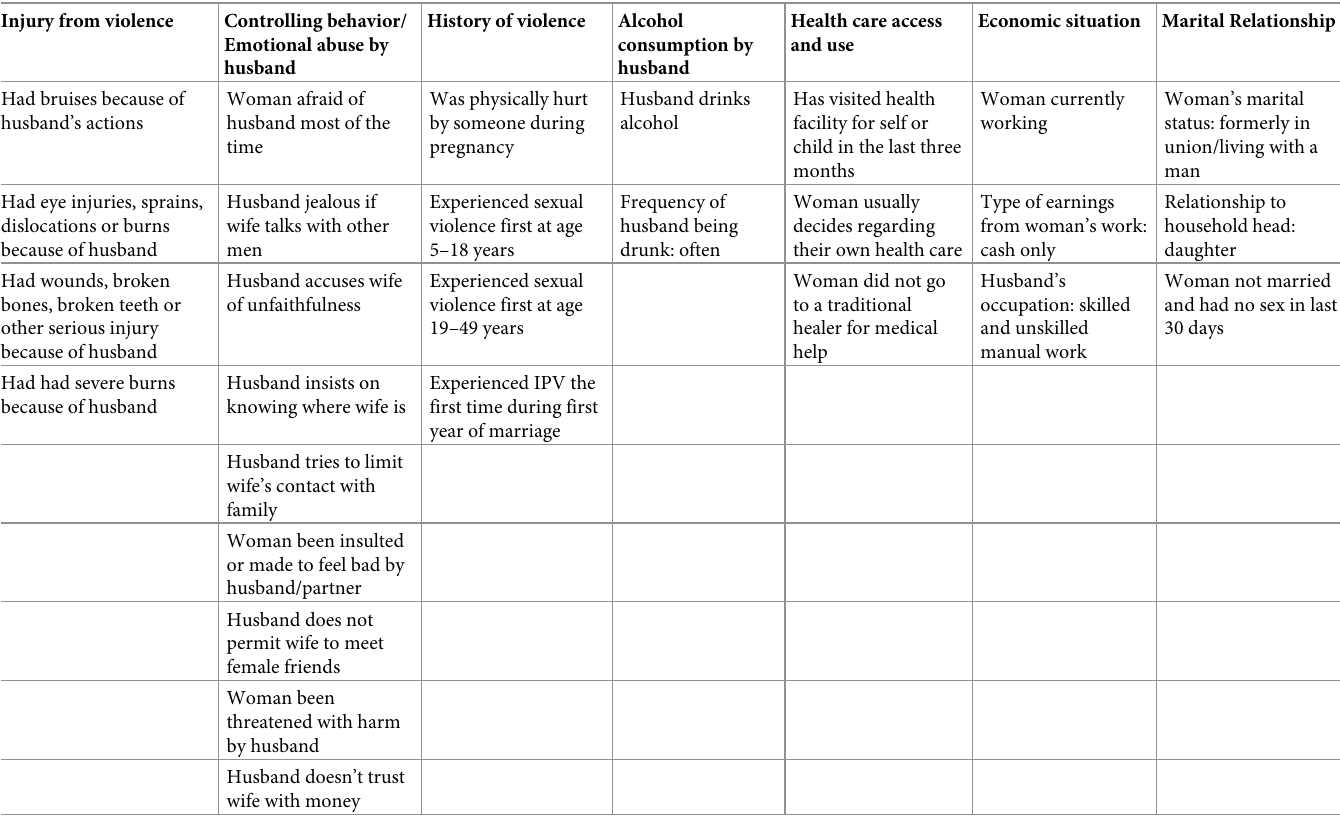
Table 3. Themes and their corresponding variables correlated with IPV help-seeking from formal institutions, based on iterative thematic analysis (ITA). Injury from